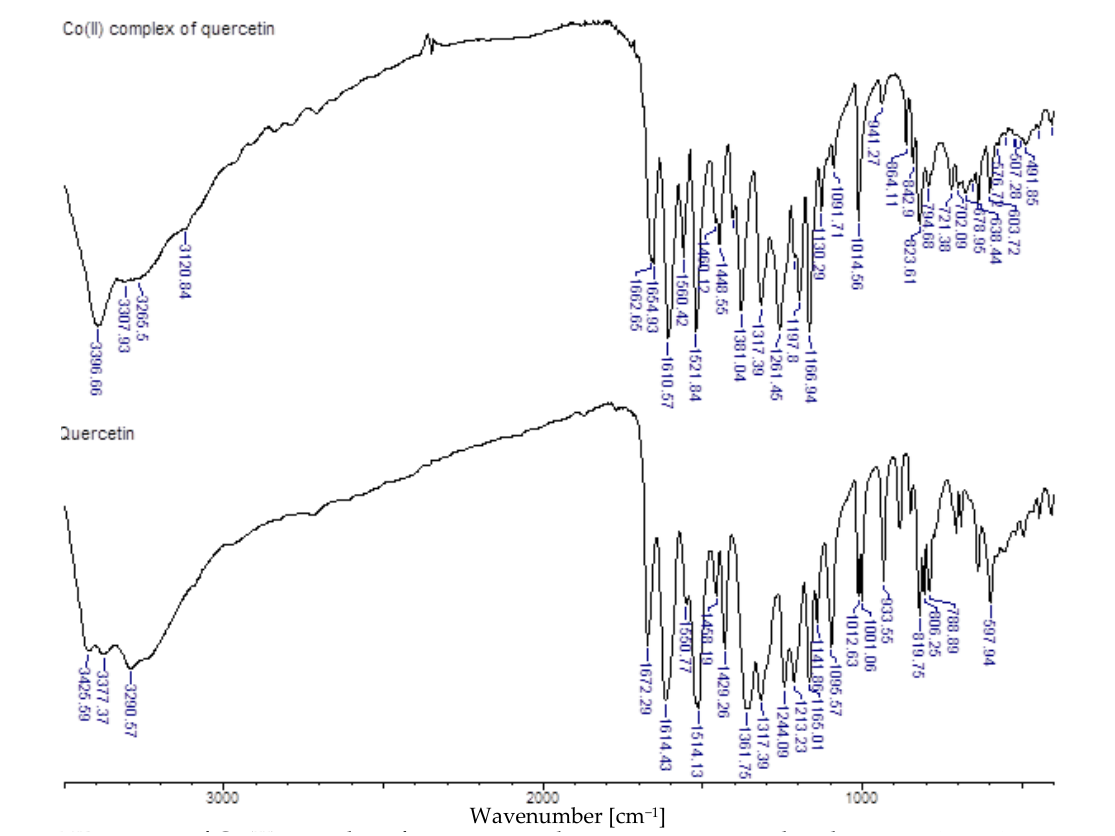
Figure 2. The FT-IR spectra of Co(II) complex of quercetin and quercetin registered in the range 4000 – 400 cm −1 .